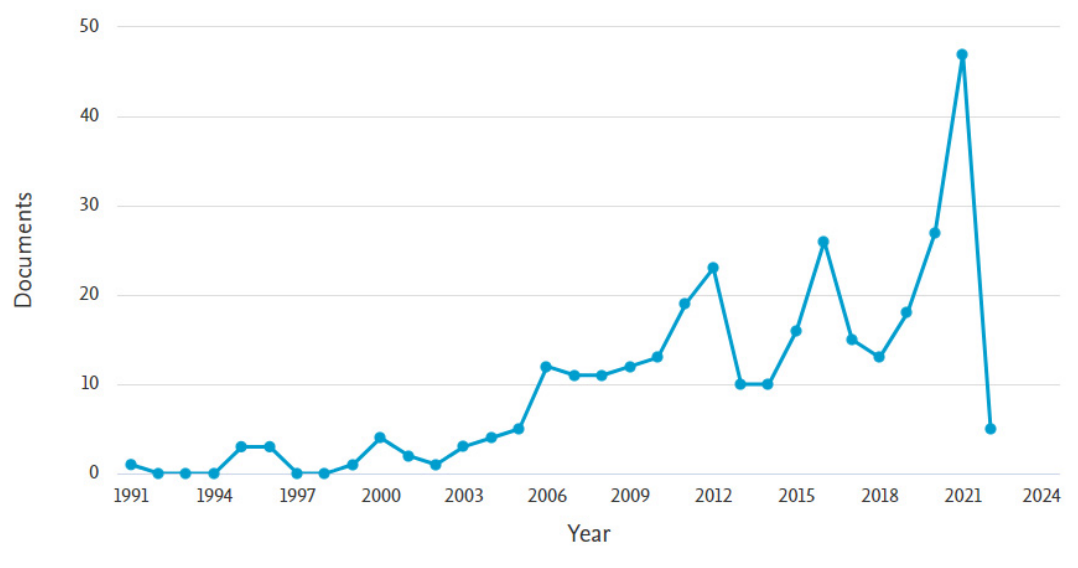
Figure 3. Annual publication growth of Performance evaluation of e-LMED.